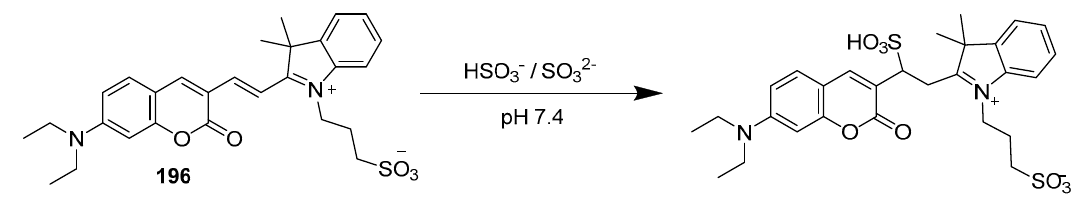
Figure 62. Chemical structure of probe 196 .